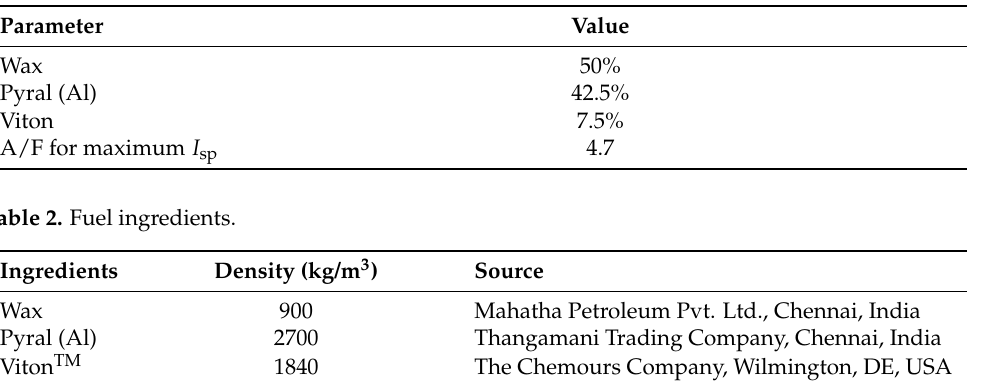
Table 1. Fuel parameters.